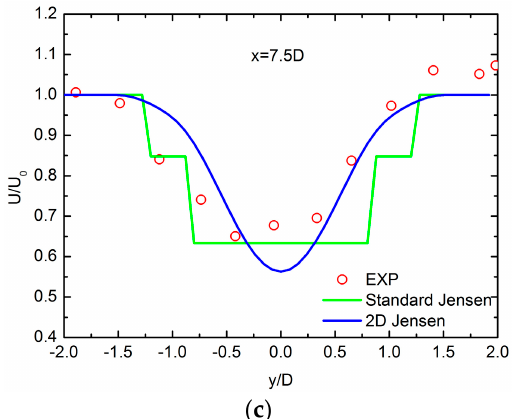
Figure 6. Comparisons between the measured and simulated wake velocity data of two wind turbines at down-stream positions of ( a ) 2.5D, ( b ) 4.0D and ( c ) 7.5D.